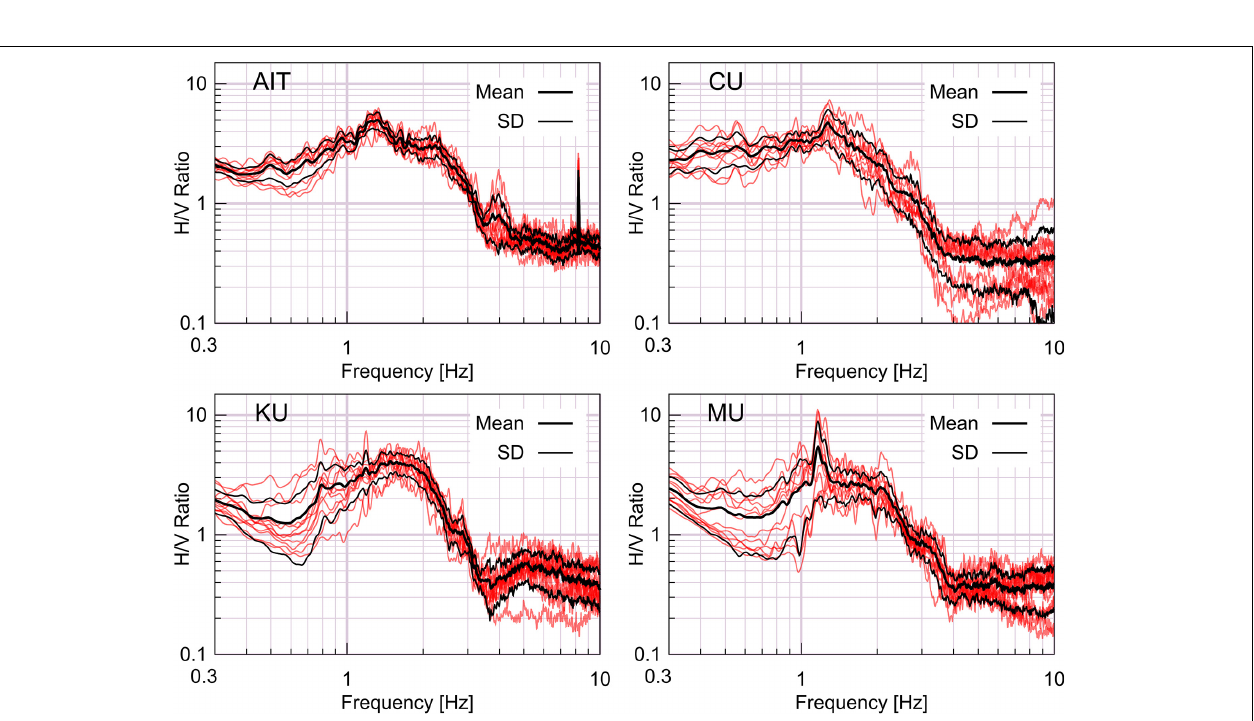
FIGURE 7 | H/V spectra at four survey sites. At each site, the red lines are the H/V ratios from multiple single-point recordings. Mean and mean ± one standard deviation are plotted with black lines.